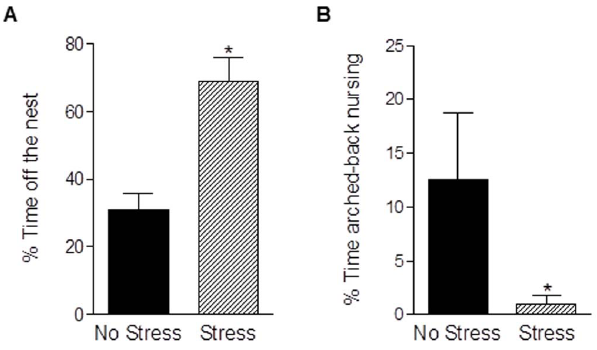
Figure 3. Chronic gestational stress impairs postpartum maternal care. Exposure to chronic stress during pregnancy increased the percentage of time postpartum females spent away from the nest (a) and reduced arched-back nursing (b). Bars represent mean 6 SEM, * p ,